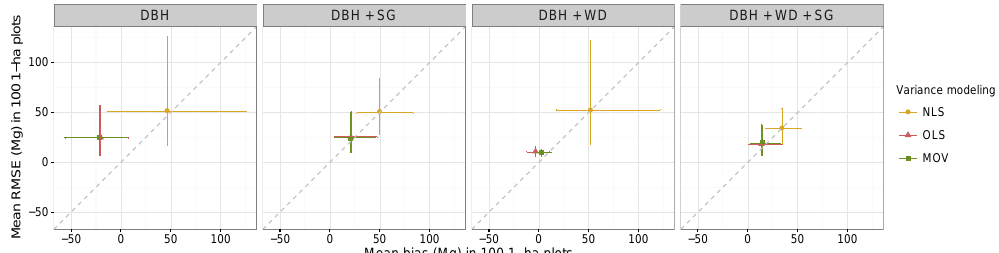
Figure 6. Overall performance of 12 aboveground tree estimation models along six forest scenarios composed of 100 1ha plots. Forest sce- narios were designed to reflect landscape-level variations in floristic composition and size distribution of trees, typical of central Amazonian terra firme forests. Models are rated by the absolute mean bias and root-mean-square error (RMSE), both in Mg. Solid points and bars rep- resent absolute mean and range values, respectively. Models’ predictors: diameter at breast height (DBH) (cm), species’ successional group (SG) (pioneers, mid- and late successional) and wood density (WD) (gcm − 3 ) . Variance modeling approaches: nonlinear least square (NLS), ordinary least square with log-linear regression (OLS) and nonlinear with modeled variance (MOV). Note that models containing tree total height ( H ) as predictor were excluded